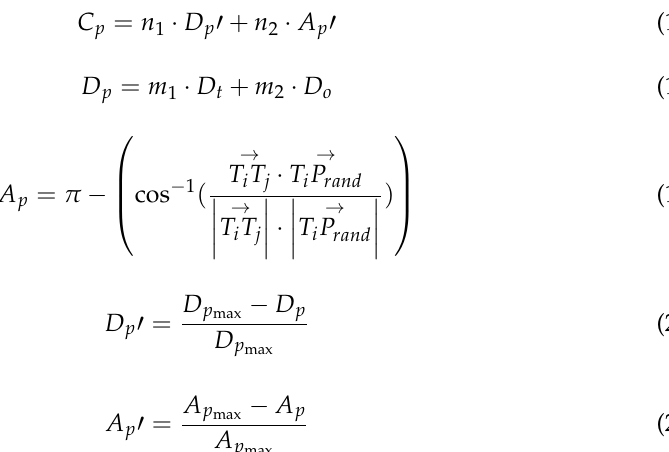
T , a more useful measurement function is introduced to se- C T . The value p of the measurement function is the ' D p and the angle cost P .